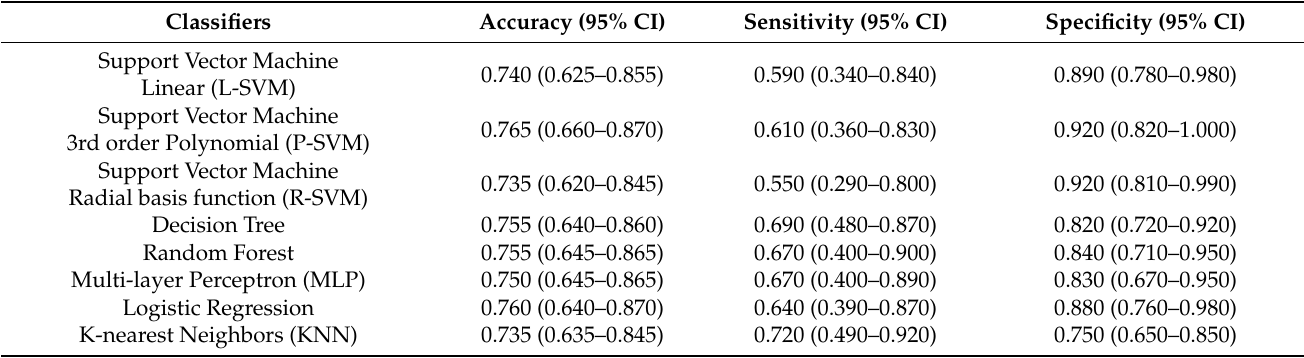
Table 7. Machine-learning results for TG